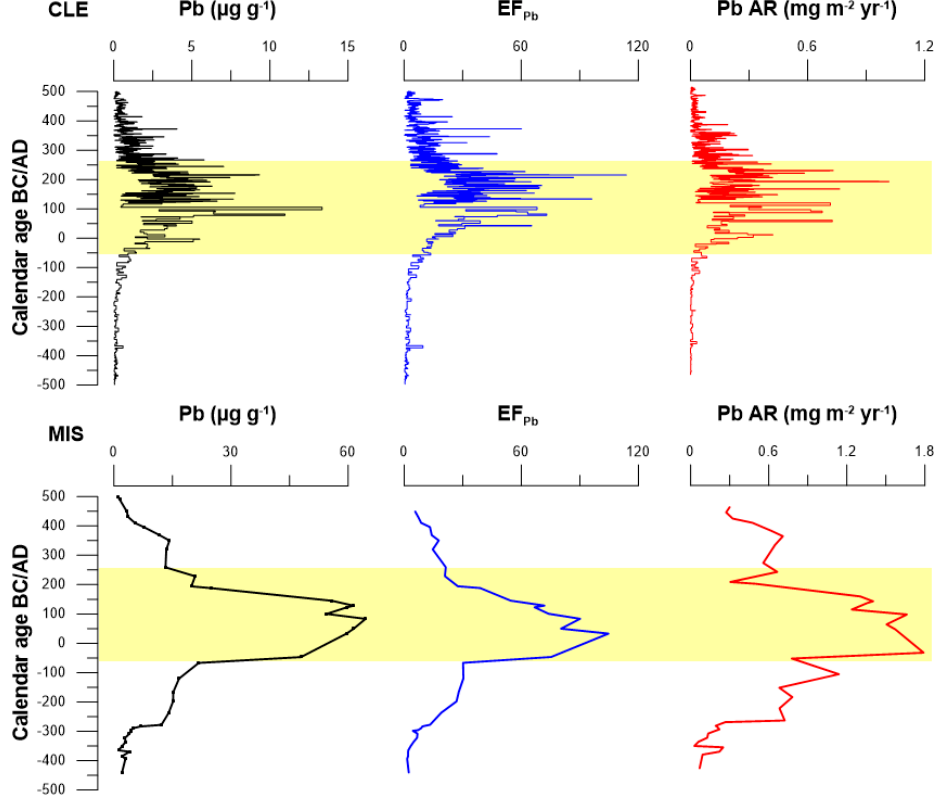
Figure 3. Summary of Pb concentration, EF Pb , and calculated Pb AR (in mg m − 2 yr − 1 ) for CLE and MIS cores. The yellow zone corresponds to the zenith Roman Empire.